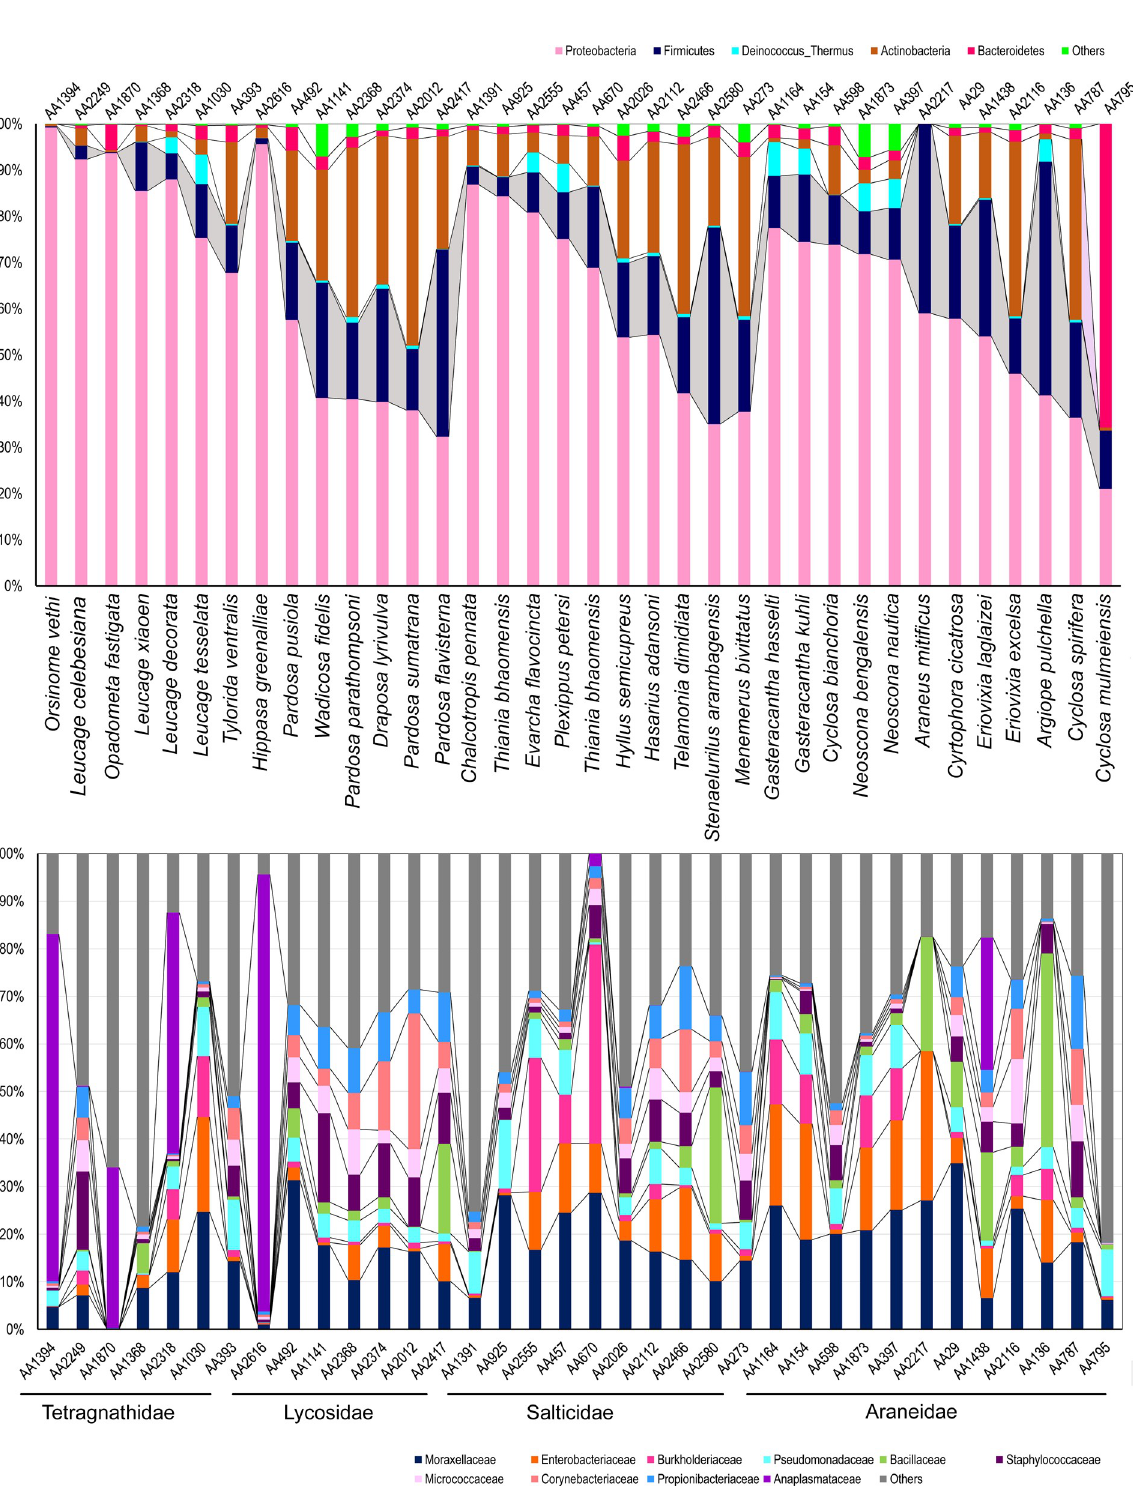
PLOS ONE | https://doi.org/10.1371/journal.pone.0251790 July 21,